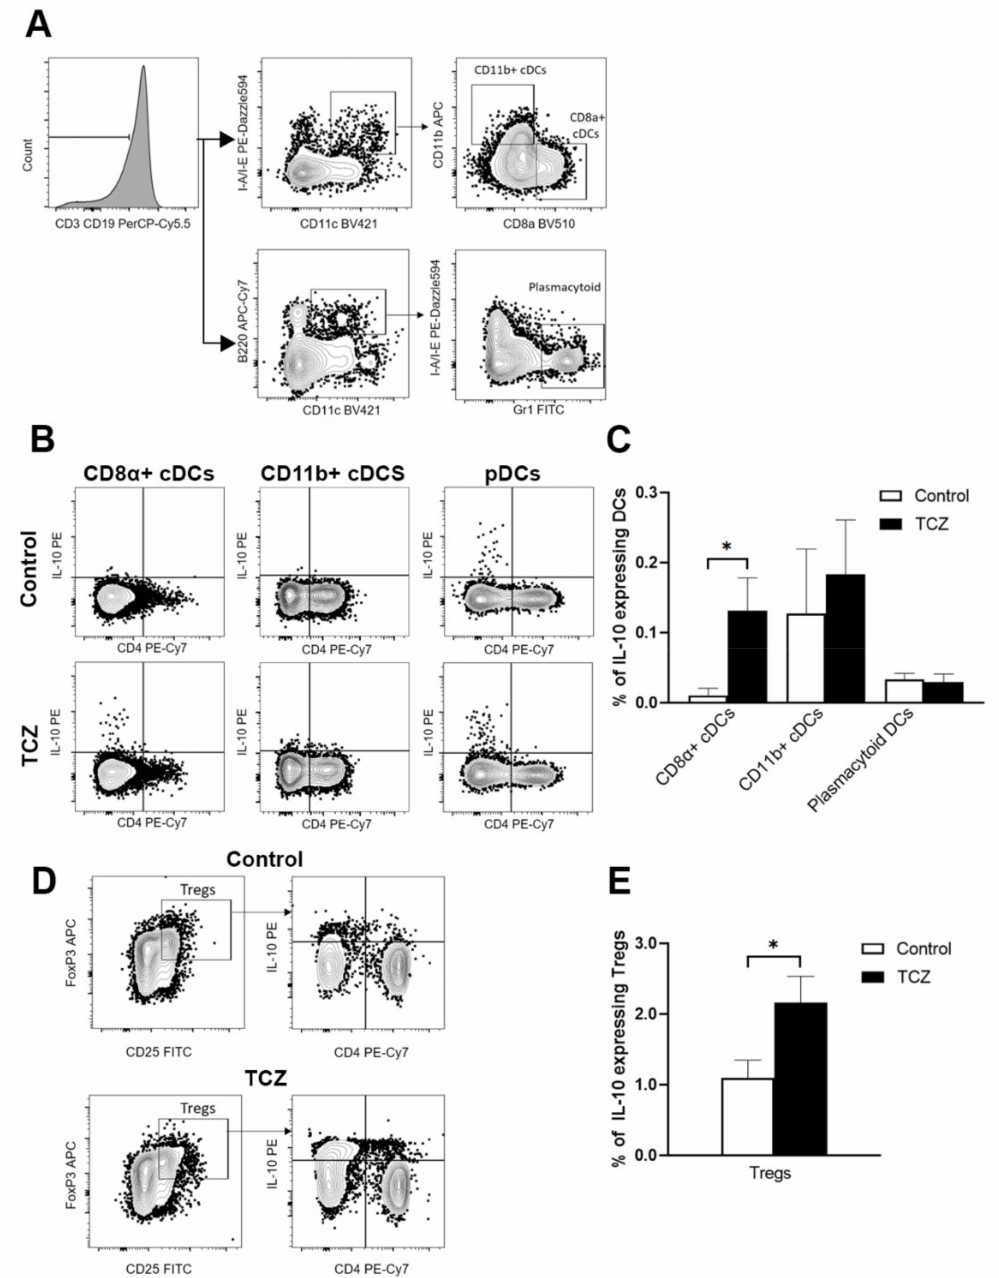
Figure 4. FACS gating strategy and percentage population. Mice were infected with C. albicans on D0, followed by treatment with either tocilizumab or saline on D2 and D4. Splenocytes were harvested on D5, and enumerated and stained with fluorescence-conjugated antibodies to be analyzed by FACS. ( A ) Gating strategy used to sort DCs into conventional CD8 α + , CD11b+, and plasmacytoid DCs. ( B ) Representative FACS plots of IL-10 expressing DC populations in control vs. treated groups. ( C ) Percentage DC population of IL-10 producing DCs in splenocytes and n ≥ 5. * p < 0.05 for cell populations of control mice vs. cell populations of TCZ-treated mice using Mann–Whitney U test (mean ± SEM). ( D ) Representative FACS plots of peripheral blood cells being sorted into IL-10 expressing regulatory T cells. ( E ) Percentage population of IL-10 producing regulatory T cells (Tregs) in peripheral blood (mean ± SEM). * p < 0.05 for cell populations of treated mice vs. control mice using the Mann–Whitney U